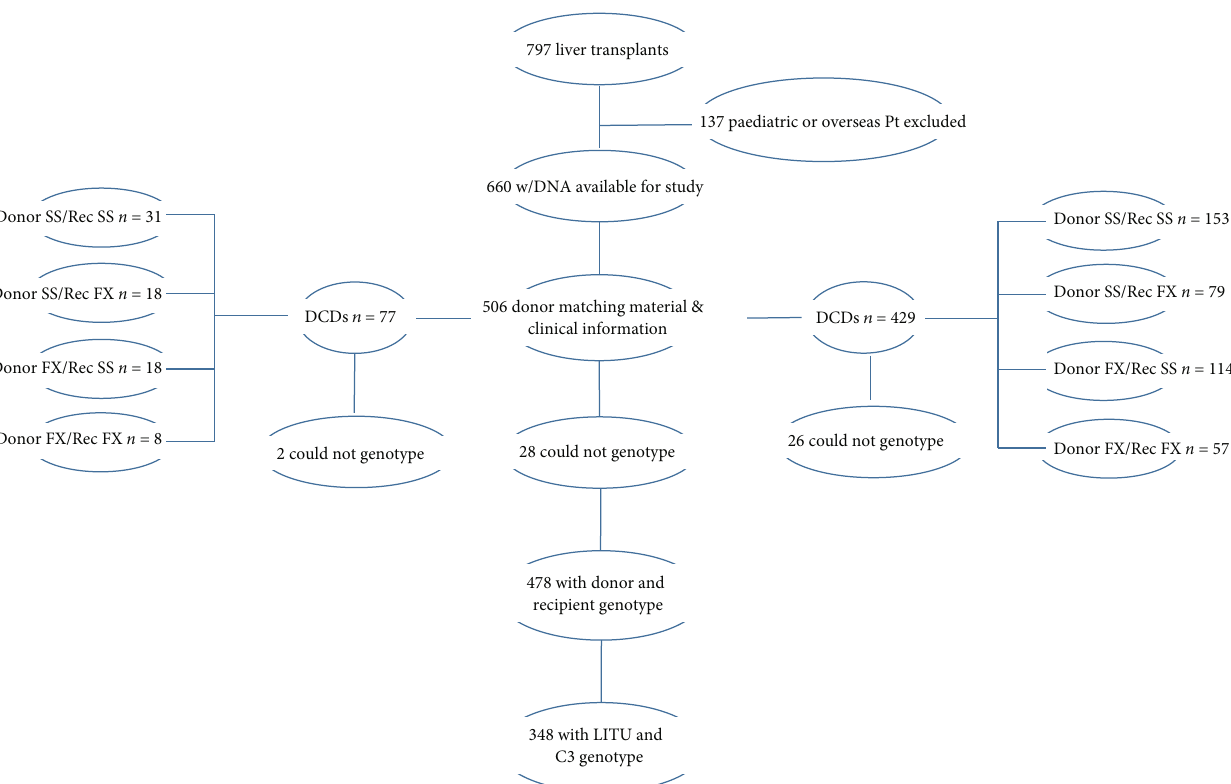
Figure 1: Liver transplant recipients eligible for study inclusion, type of donors, and genotype